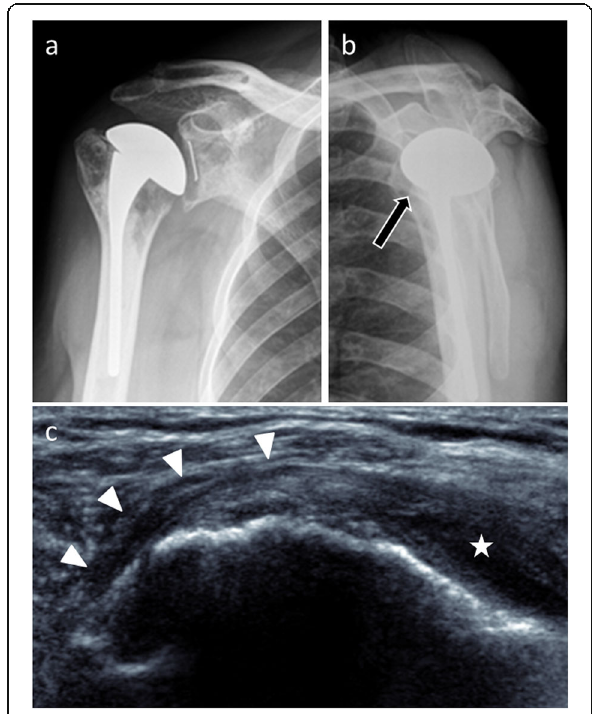
Fig. 19 Anteroposterior ( a ) and scapular Y ( b ) radiographs of a 53- year-old man with total shoulder arthroplasty shows a slight anterior translation of the humeral head (arrow). Transverse grayscale US image ( c ) of the same patient shows subscapularis tendon rupture (arrowheads) with a retracted tendinous stump (star)